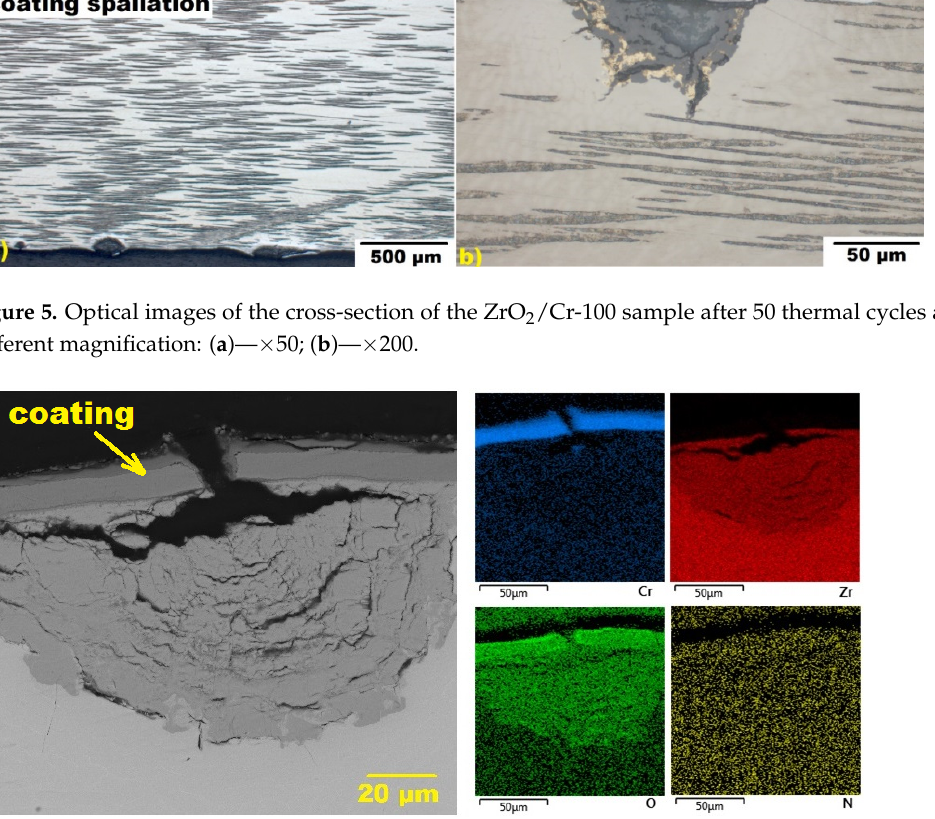
Figure 6. Cross-section SEM image of the ZrO 2 /Cr-750 sample after 50 cycles and corresponding EDS maps of Cr, Zr, O, and N.